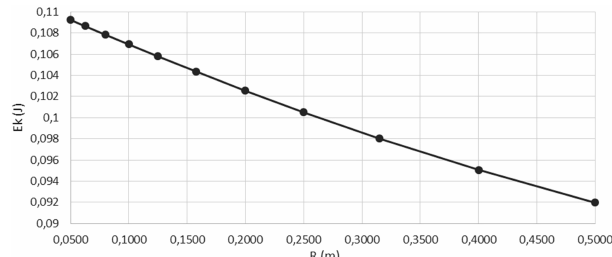
Figure 7. Dependence of kinetic energy E k and radius R of the drive pulley at velocity v 0 = 4ms − 1 .